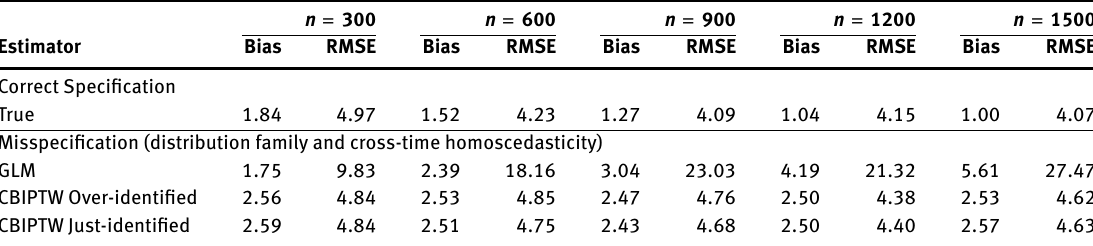
Table 2: Performance of Probability Weights Estimation Methods (Gamma Heteroscedastic Treatment-Assignment DGP). n = 300 n = 600 n = 900 n = 1200 n = 1500